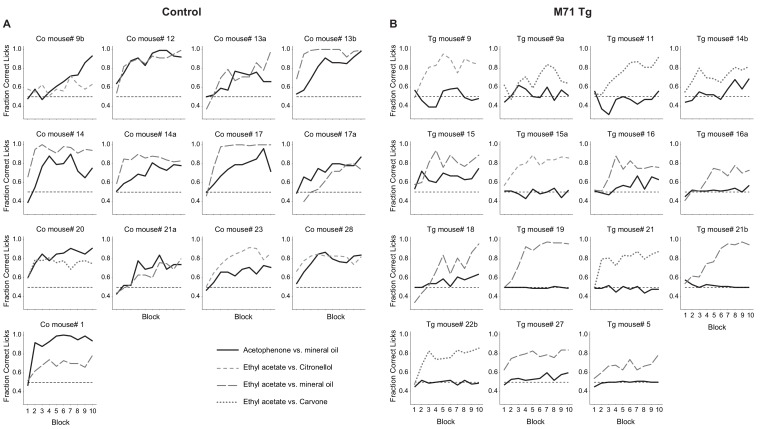
M71 transgenic mice fail to detect acetophenone in a go/no go operant conditioning task.(A) Wild-type mice consistently discriminate acetophenone from its diluent mineral oil (black lines). Wild-type mice also discriminate between other pairs of odorants (ethyl acetate versus mineral oil, citronellol, or carvone, dotted lines). (B) M71 transgenic mice consistently fail to discriminate acetophenone from mineral oil, but readily discriminate between the other pairs of odorants.